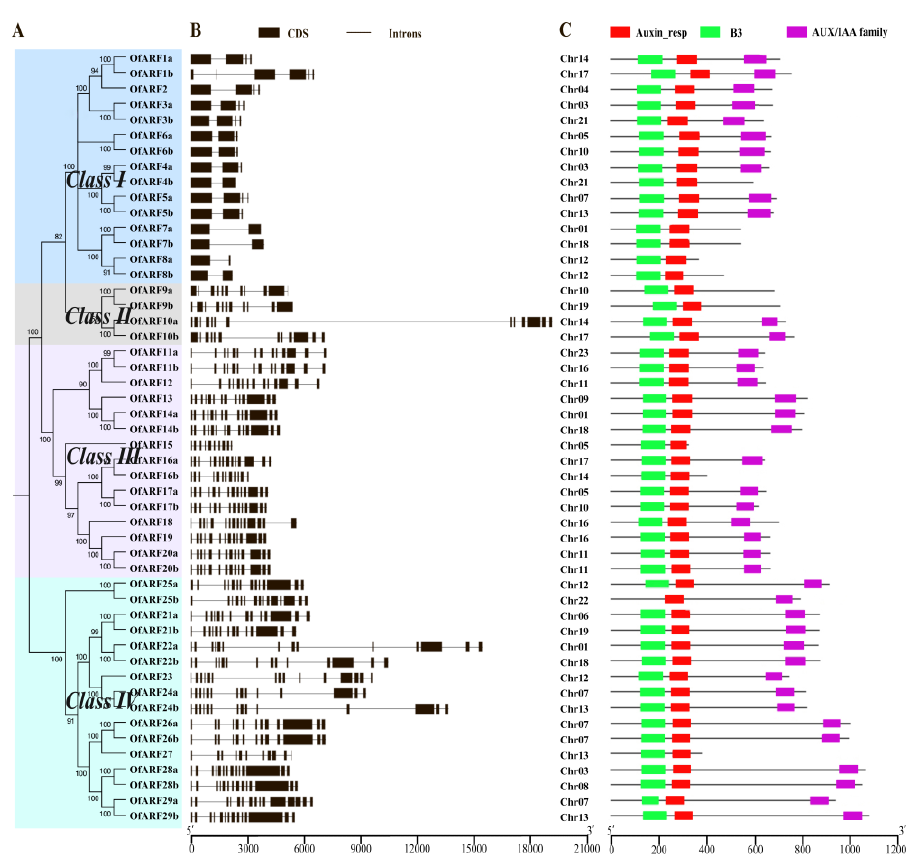
Figure 2. Phylogenetic relationship, gene structure, and conserved motif analysis of the Osmanthus fragrans auxin response factor ( OfARF ) gene family. ( A ) Phylogenetic analysis of OfARF proteins. A total of 50 OfARF proteins from O . fragrans were used to construct the neighbor-joining tree. ( B ) Gene structure analysis of OfARF s. The lengths of coding sequences (CDSs) and introns of each OfARF gene are displayed proportionally. The black blocks represent CDSs and black lines represent introns. ( C ) Conserved motif analysis of OfARF proteins. The B3, AUX_RESP, and AUX_IAA domains are marked in brown, orange, and green, respectively.